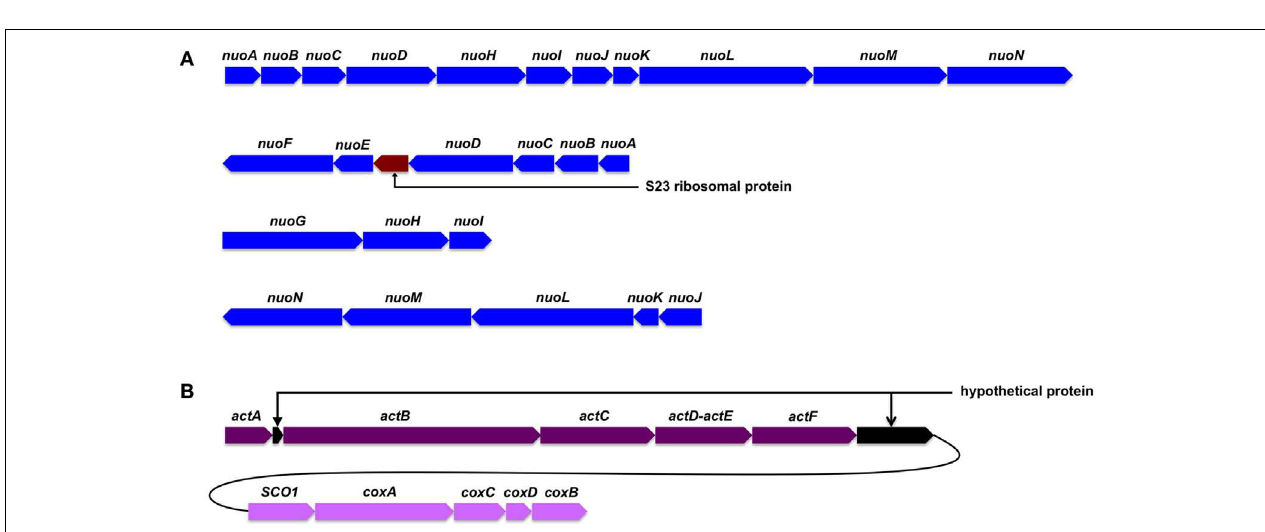
FIGURE 6 | Cellular overview of I. album metabolism deduced from its genome sequence. Only selected pathways and enzymes discussed in the text are shown. Blue arrows indicate pathways of electron flow. NDH-1,